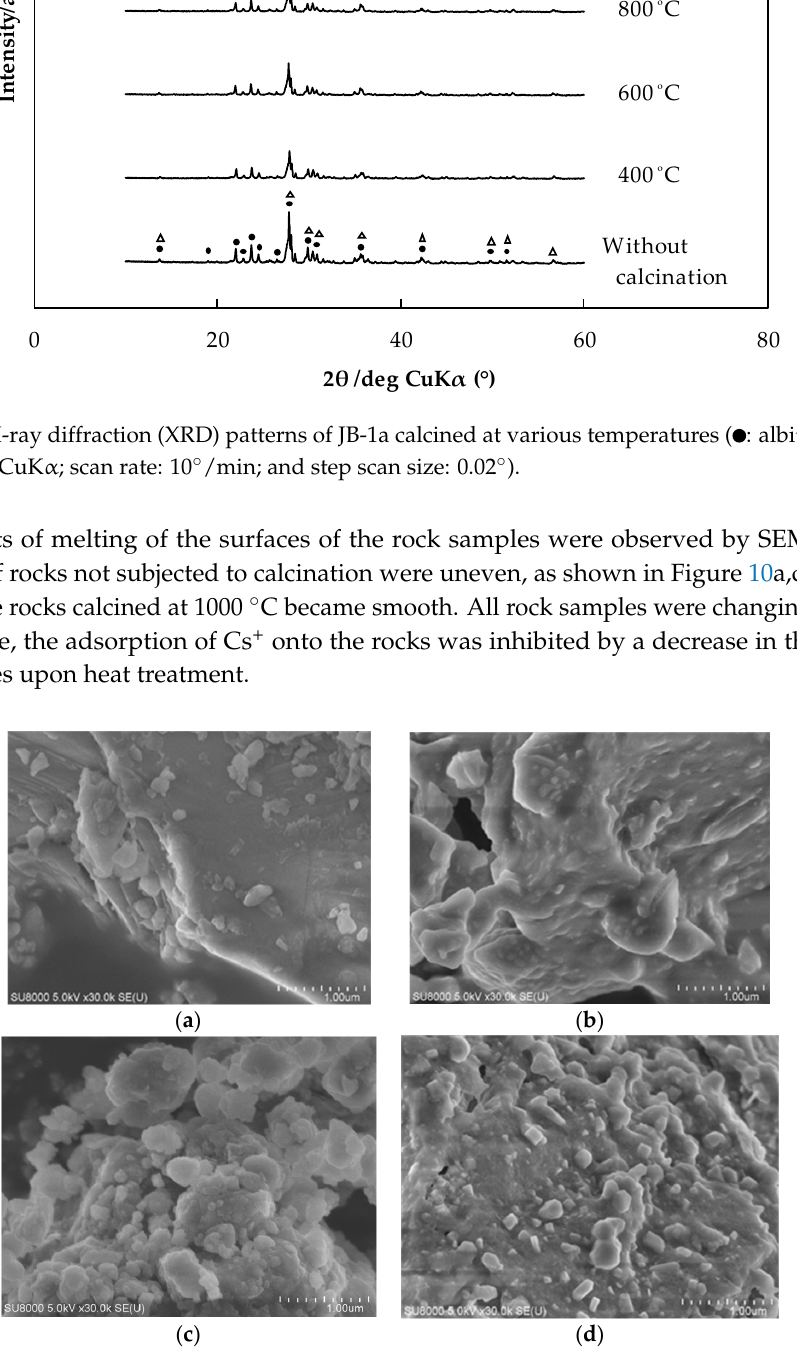
Figure 10. Scanning electron microscopy (SEM) images of ( a ) JB-1a and ( c ) JSO-1 without calcination and ( b ) JB-1a and ( d ) JSO-1 after calcination at 1000 °C; magnification: 30,000×.